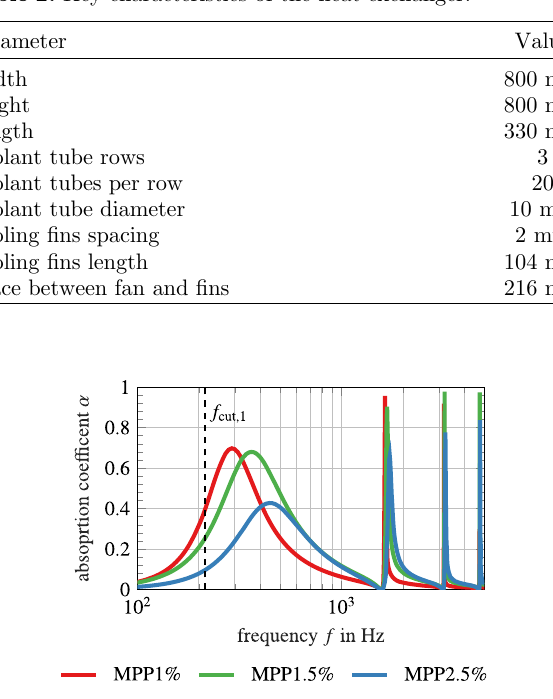
Figure 3. Characteristic curves of the forward skewed axial fan with heat exchangers, (a) aerodynamic curve and (b) acoustic curve.